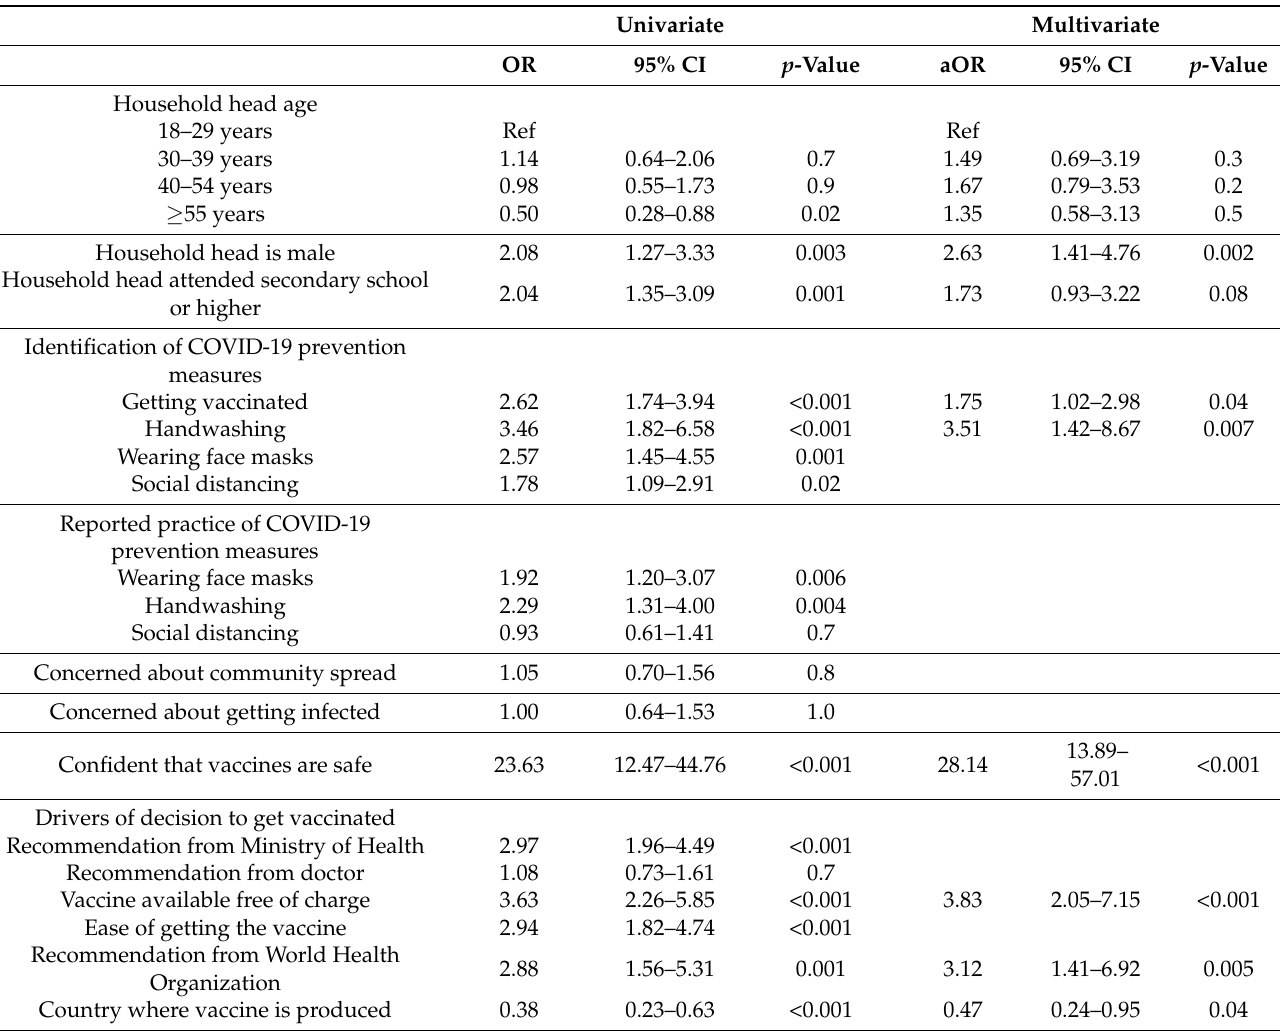
Table 2. Factors influencing vaccine intentions among heads of households in Manicaland Province. Univariate